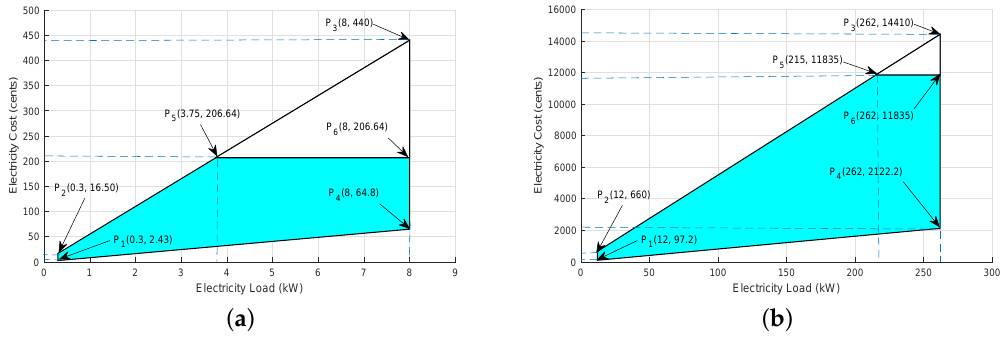
Figure 5. Feasible region for cost and electricity consumption using CPP. ( a ) Feasible region for a single home; ( b ) feasible region for multiple homes.